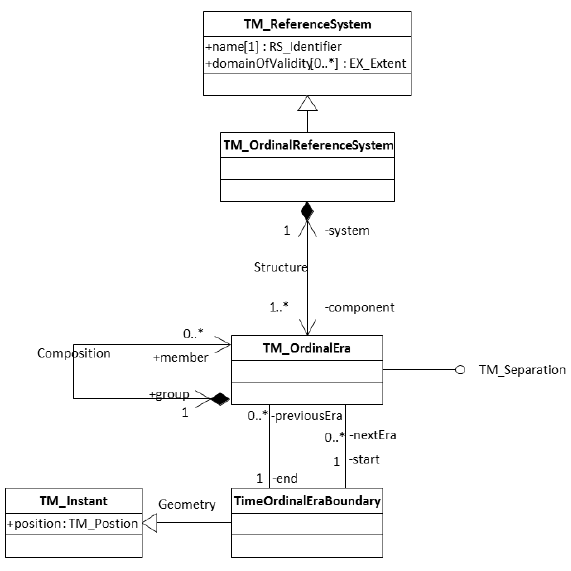
Figure 8 Model for temporal reference systems adapted from ISO 19108 by Cox and Richard